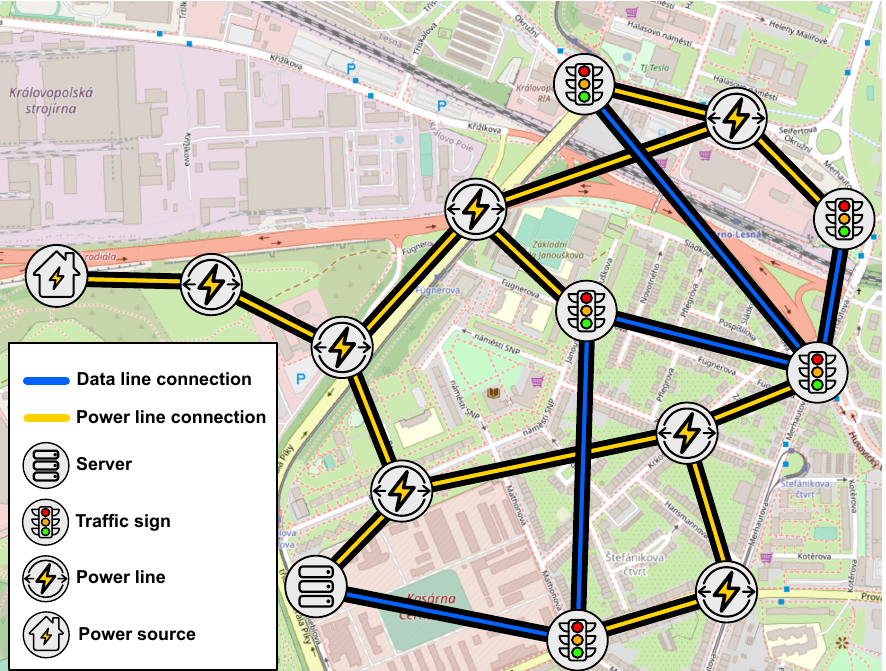
Figure 8. Example of a graphical interface illustrating a power lines and data network connections